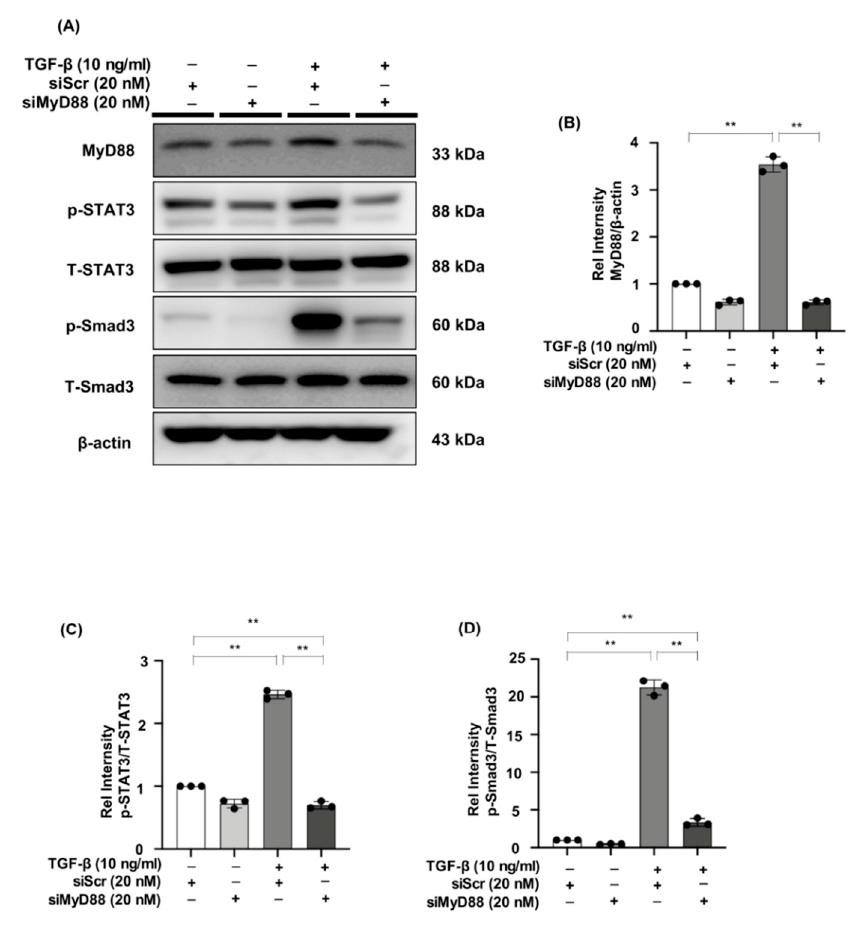
Figure 7. MyD88 silencing suppresses STAT3 and Smad3 phosphorylation in TGF- β stimulated NRK49F cells. ( A ) Western blotting revealed that p-STAT3 and p-Smad3 expression was blocked by siMyD88 transfection in TGF- β stimulated NRK49F cells. NRK49F cells were transfected with siMyD88 or siScr for 24 h in high-glucose DMEM without FBS, starved with 0.5% FBS medium, and then treated with TGF- β (10 ng/mL) for 30 min. Western blot demonstrated that MyD88 expression was significantly reduced by the specific siRNA. ( B – D ) Statistical significance was presented as the mean ± SD, n = 3. ** p < 0.01, ns: no significance.